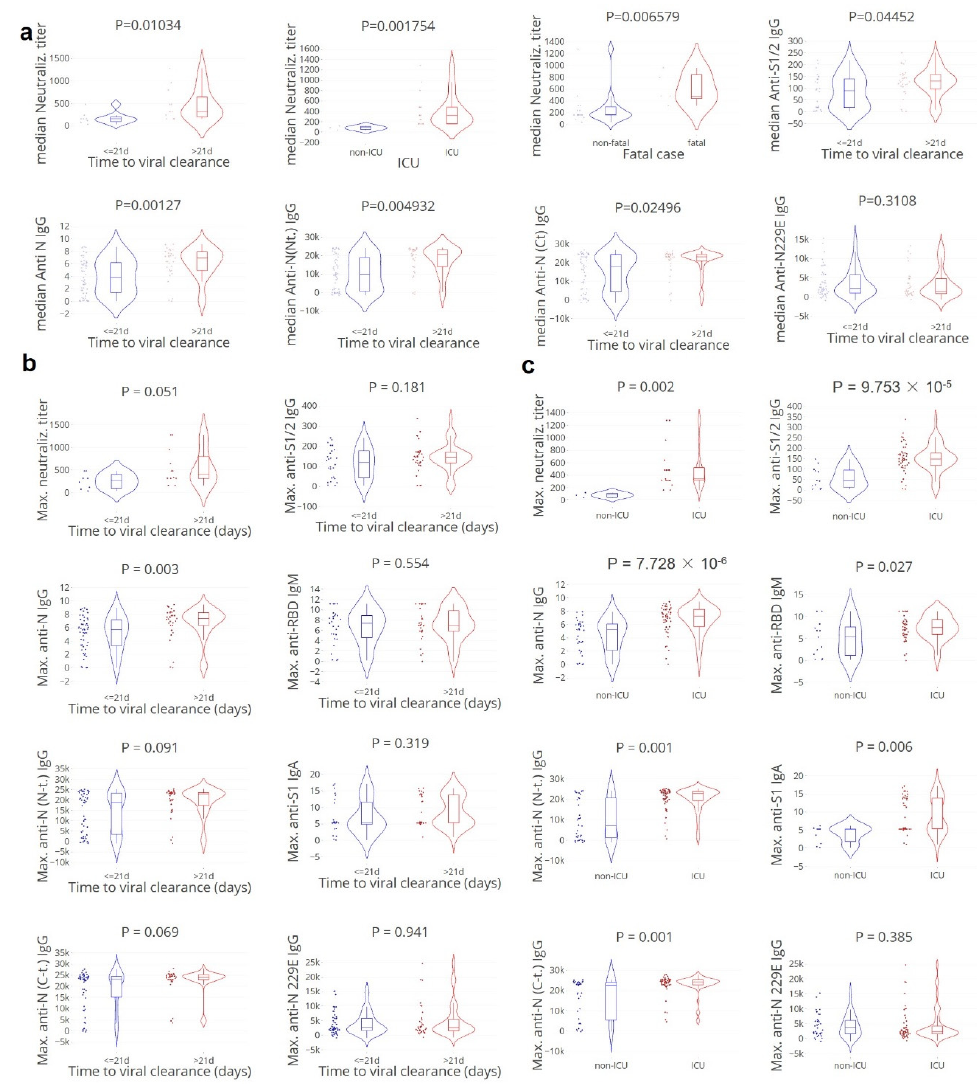
Figure 3. Apparent paradoxical higher (neutralising) antibody titers in cases with delayed clearance, ICU admittance, and fatality. Anti-HCOV-229E IgG was included as negative control (see Supplementary Figure S1). ( a ). Median values per patient grouped by the time to viral clearance: ≤ 21 (blue)/> 21 (red) days, ICU admittance, and fatality. Mann–Whitney U test. ( b , c ). Maximum values, grouped by the time to viral clearance: ≤ 21 (blue)/> 21 (red) days, and ICU admittance. C-term./C-t.; C-terminal, N-term/N-t.; N-terminal. Neutralisation titer; 20 patients, 50 samples. Anti-S1/2 IgG; 58 patients, 158 samples. Anti-N IgG 82 patients, 196 samples. Anti-N(N/C terminus IgG and anti-N229 IgG; 84 patients, 187 samples. Mann–Whitney U test.